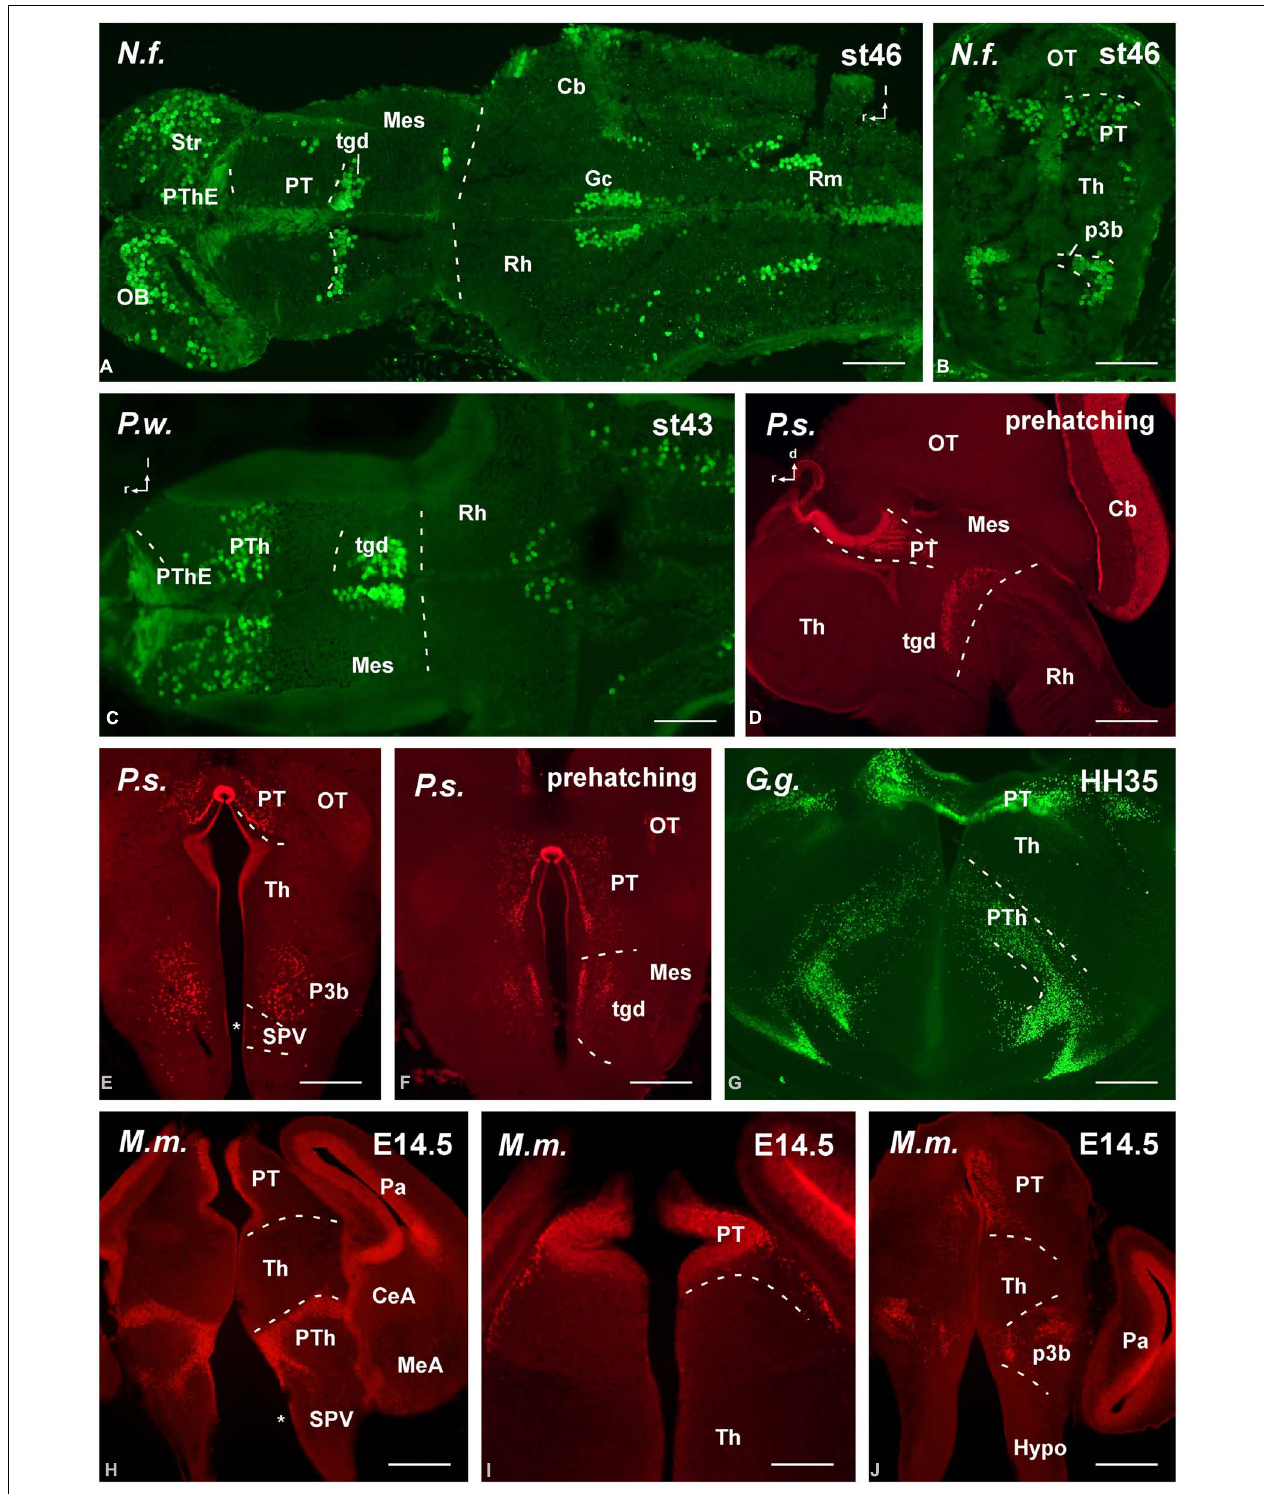
FIGURE 5 | Photomicrographs of horizontal (A,C), transverse (B,E–J) and sagittal (D) sections at diencephalic levels that illustrate the localization of Pax6-immunoreactive cells in the pretectum of anamniotes (A–C) and amniotes (D,F–I), and in the basal portion of